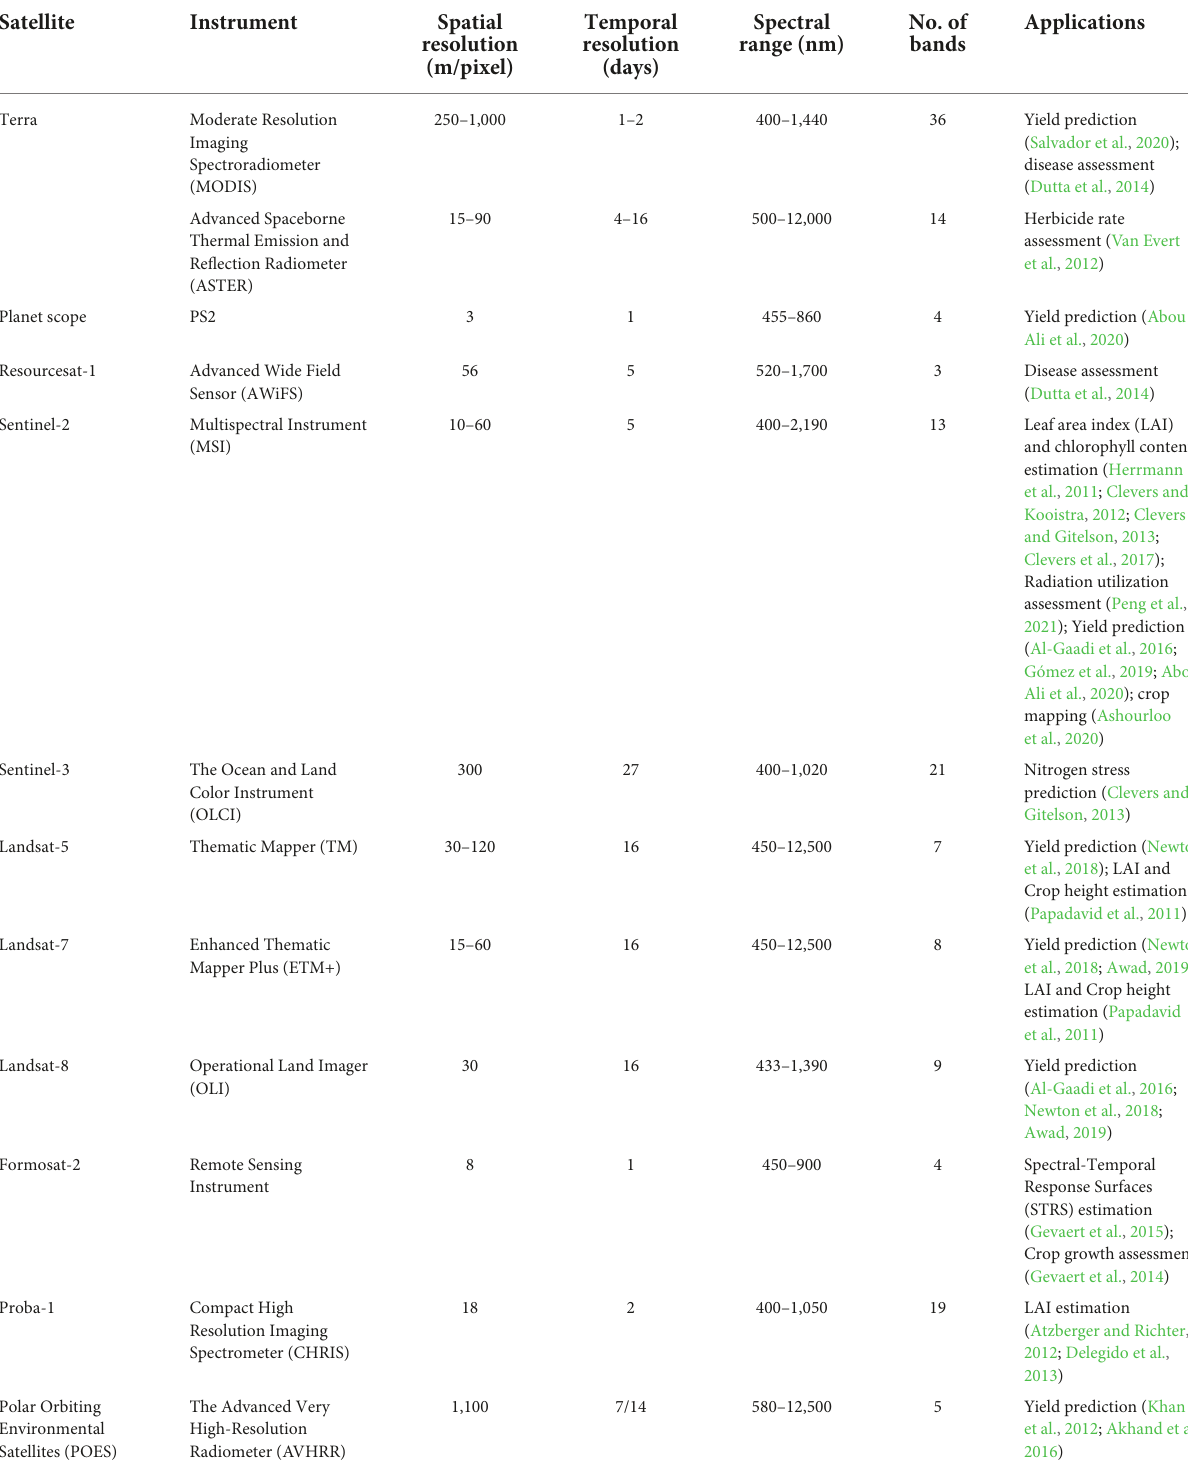
TABLE 2 Satellite-based remote sensing platforms and their applications in potato trait